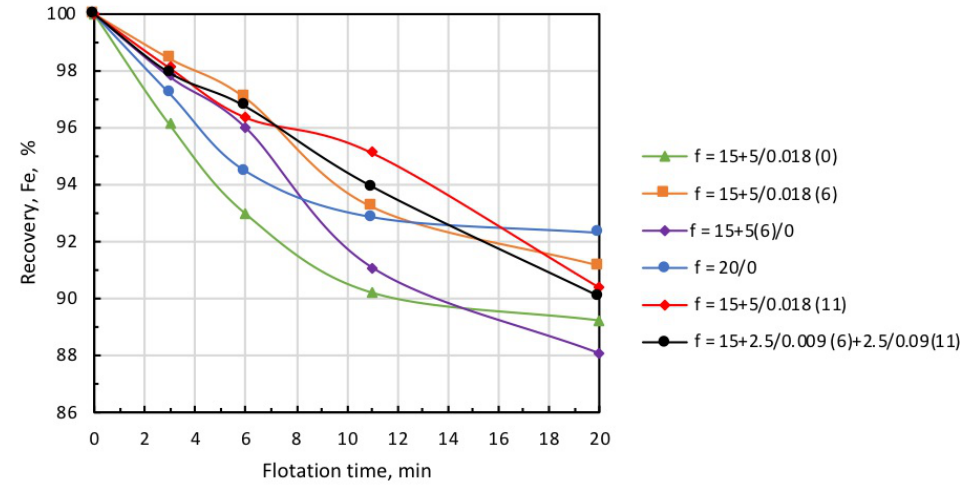
Figure 12. Iron recovery into concentrate at different modes of collector and microbubble introduction (symbols are explained in Table 3).